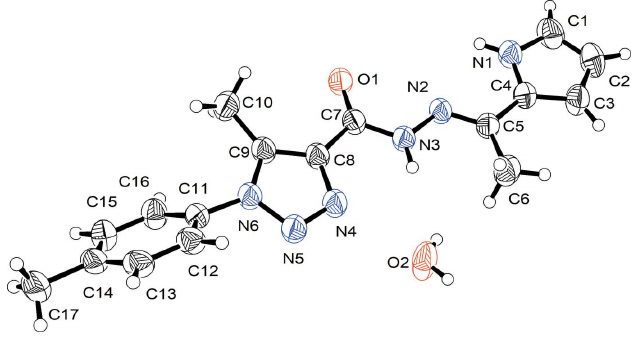
Figure 1 The molecular structure, showing 50% probability displacement ellip-